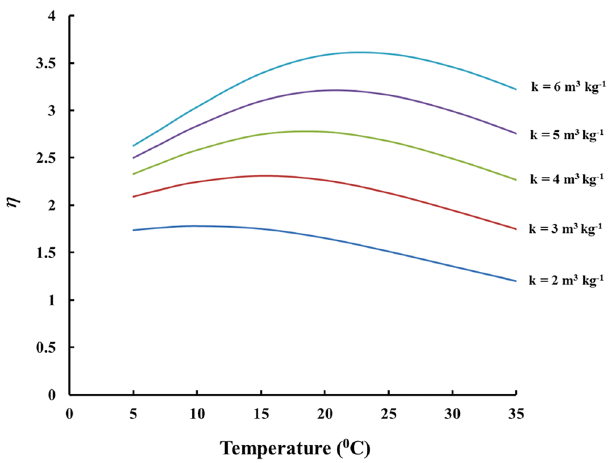
Figure 7. Temperature dependence of η = kρ of the module of Fig. 3 for different values of k .